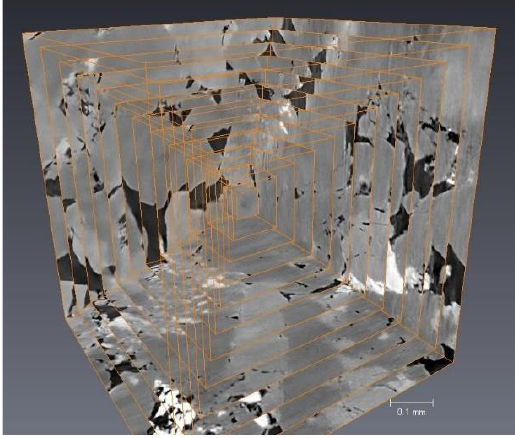
Figure 3. Workflow for imaging processing of raw CT image (left, e.g.,) through filtering, obtaining the noise-free image which is further threshold-segmented into separated pore space (blue) and rock matrix (gray) on the right.